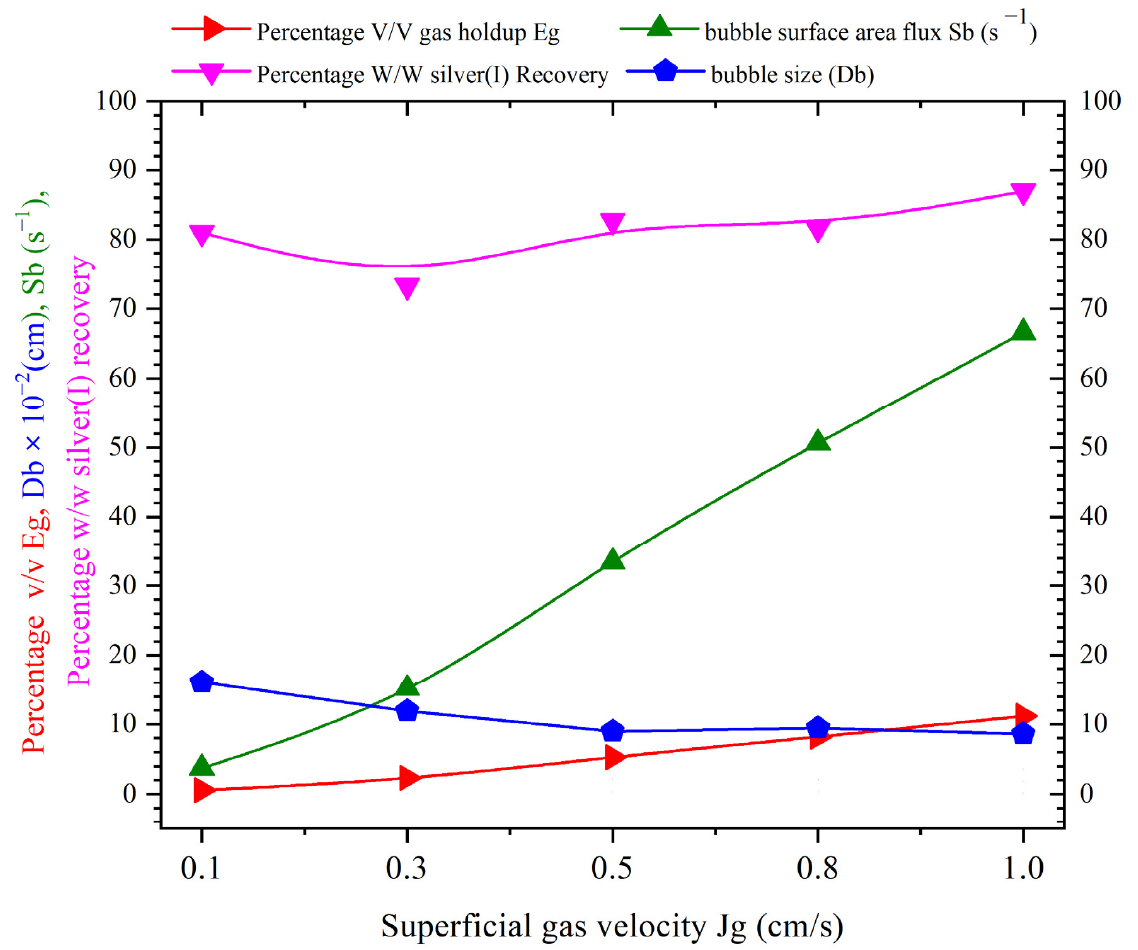
Figure 11. Eg, Db, Sb, and percentage of w / w of silver(I) ion flotation as function of superficial gas velocity, ceramic sparger, Jl 0.19 cm/s, system 1.57 × 10 − 4 of [x]—1.08 × 10 − 4 [xl2945], and [e] 1.25 × 10 − 4